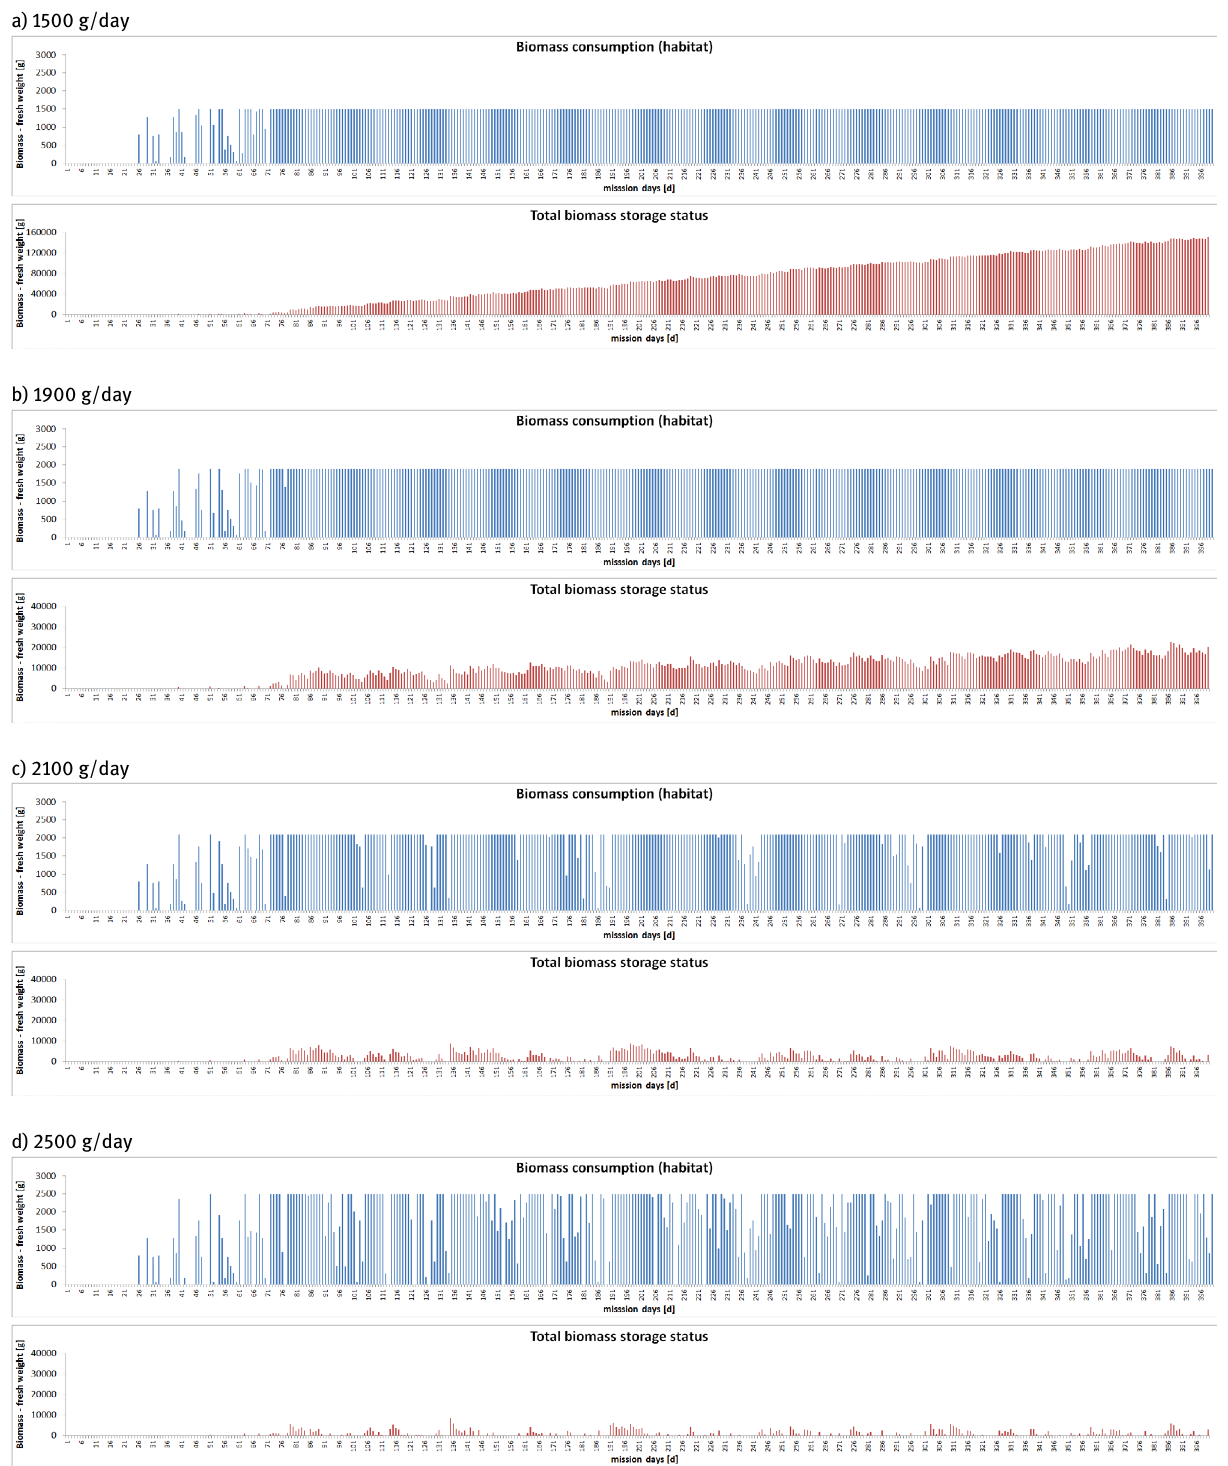
Figure 12: Different habitat biomass consumption set points versus total storage situation on a daily basis for SC. Actual biomass consump- tion by the crew (10 crew members) are marked with the blue bars for each observation day. Five habitat demand set points were defined (1500 g/d to 3000 g/d), which represents the consumption by the crew. Partial blue bars represent the actual consumption of the crew that day, incorporating the remaining biomass of the storage system (red